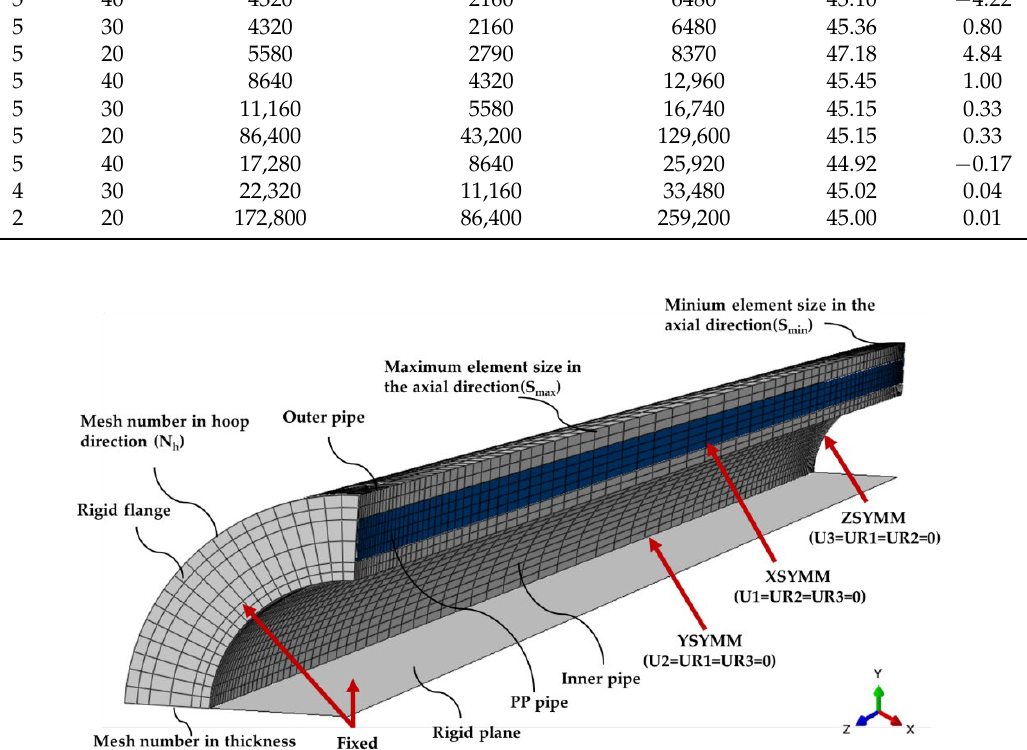
Table 5. Mesh convergence test.